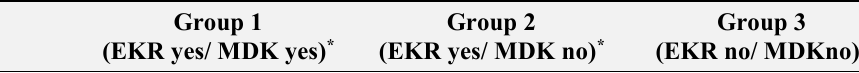
Table 3. Nursing care level of MDK patients as per first medical examination by cancer case status in cancer registry (EKR) and MDK database (cancer cases in groups 1 and 2 restricted to colon, breast and prostate